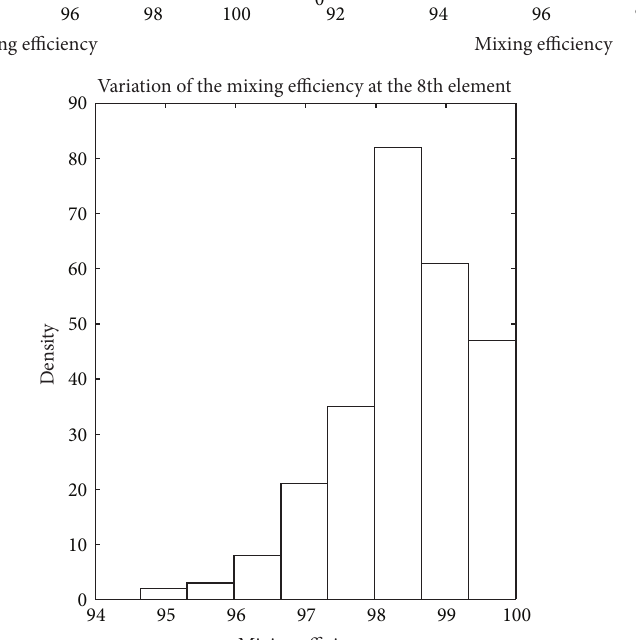
plot shows that no significant variations of the mean value of the data set are obtained after about 50 iterations. This means that the considered trial of 100 iterations of the Monte analysis of the